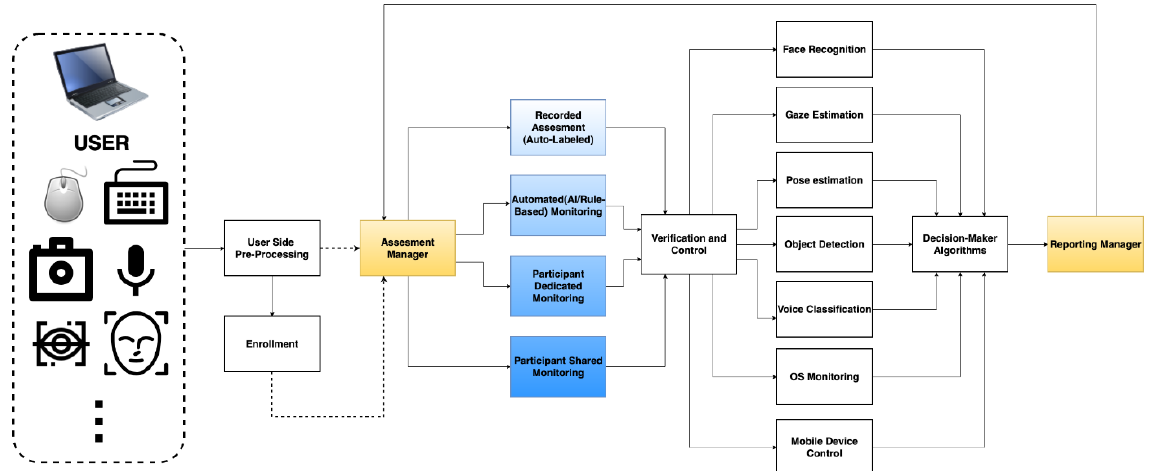
Figure 2 . The general workflow of